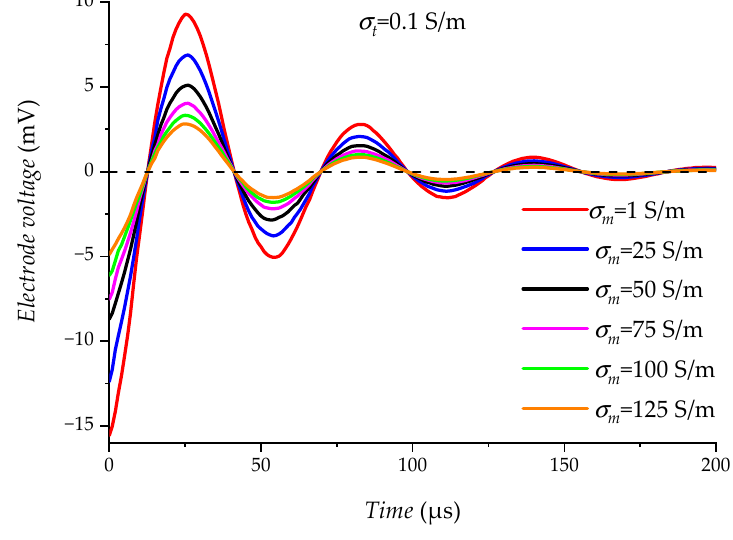
Figure 16. Relationship between σ m and U Ex